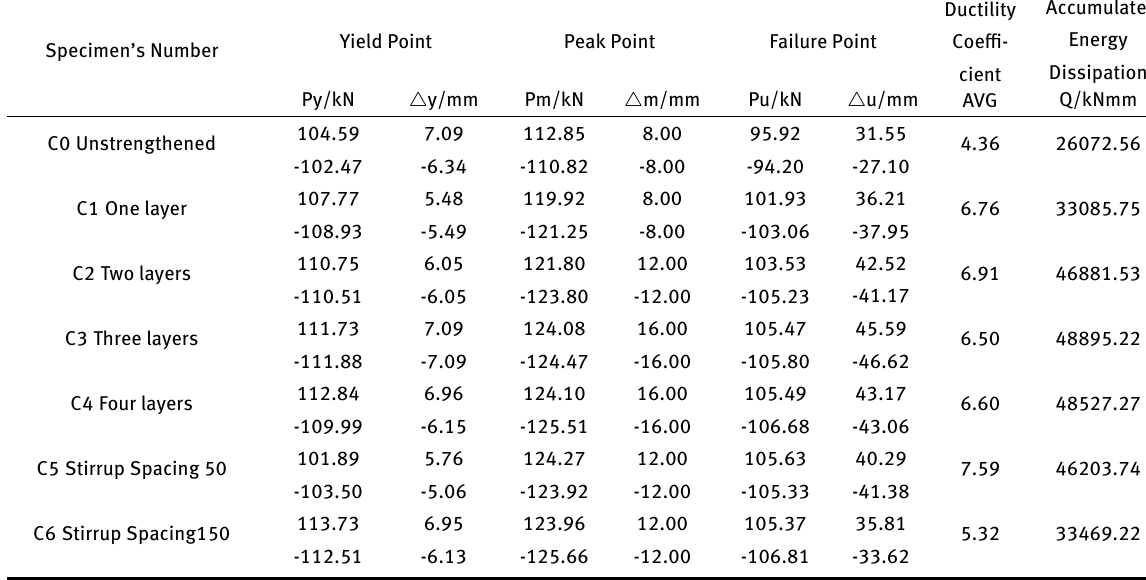
Table 5: Test results of each specimen